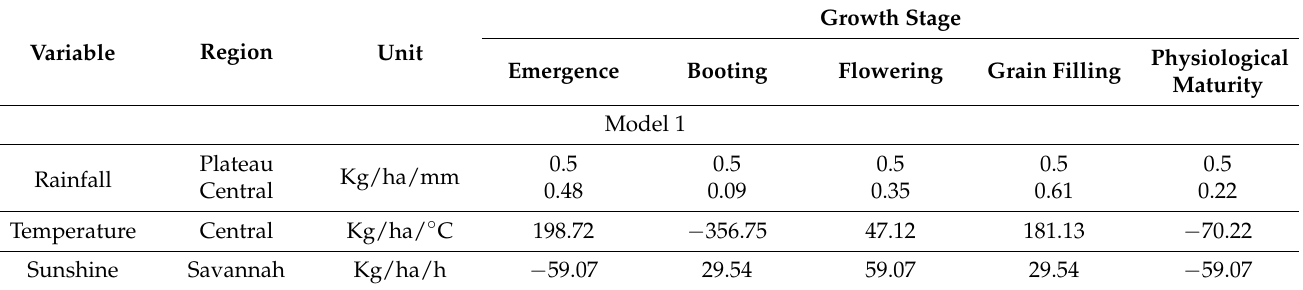
Table 8. Yield coefficients for weather-related factors on sorghum yield by growth stage from the Chebyshev polynomial